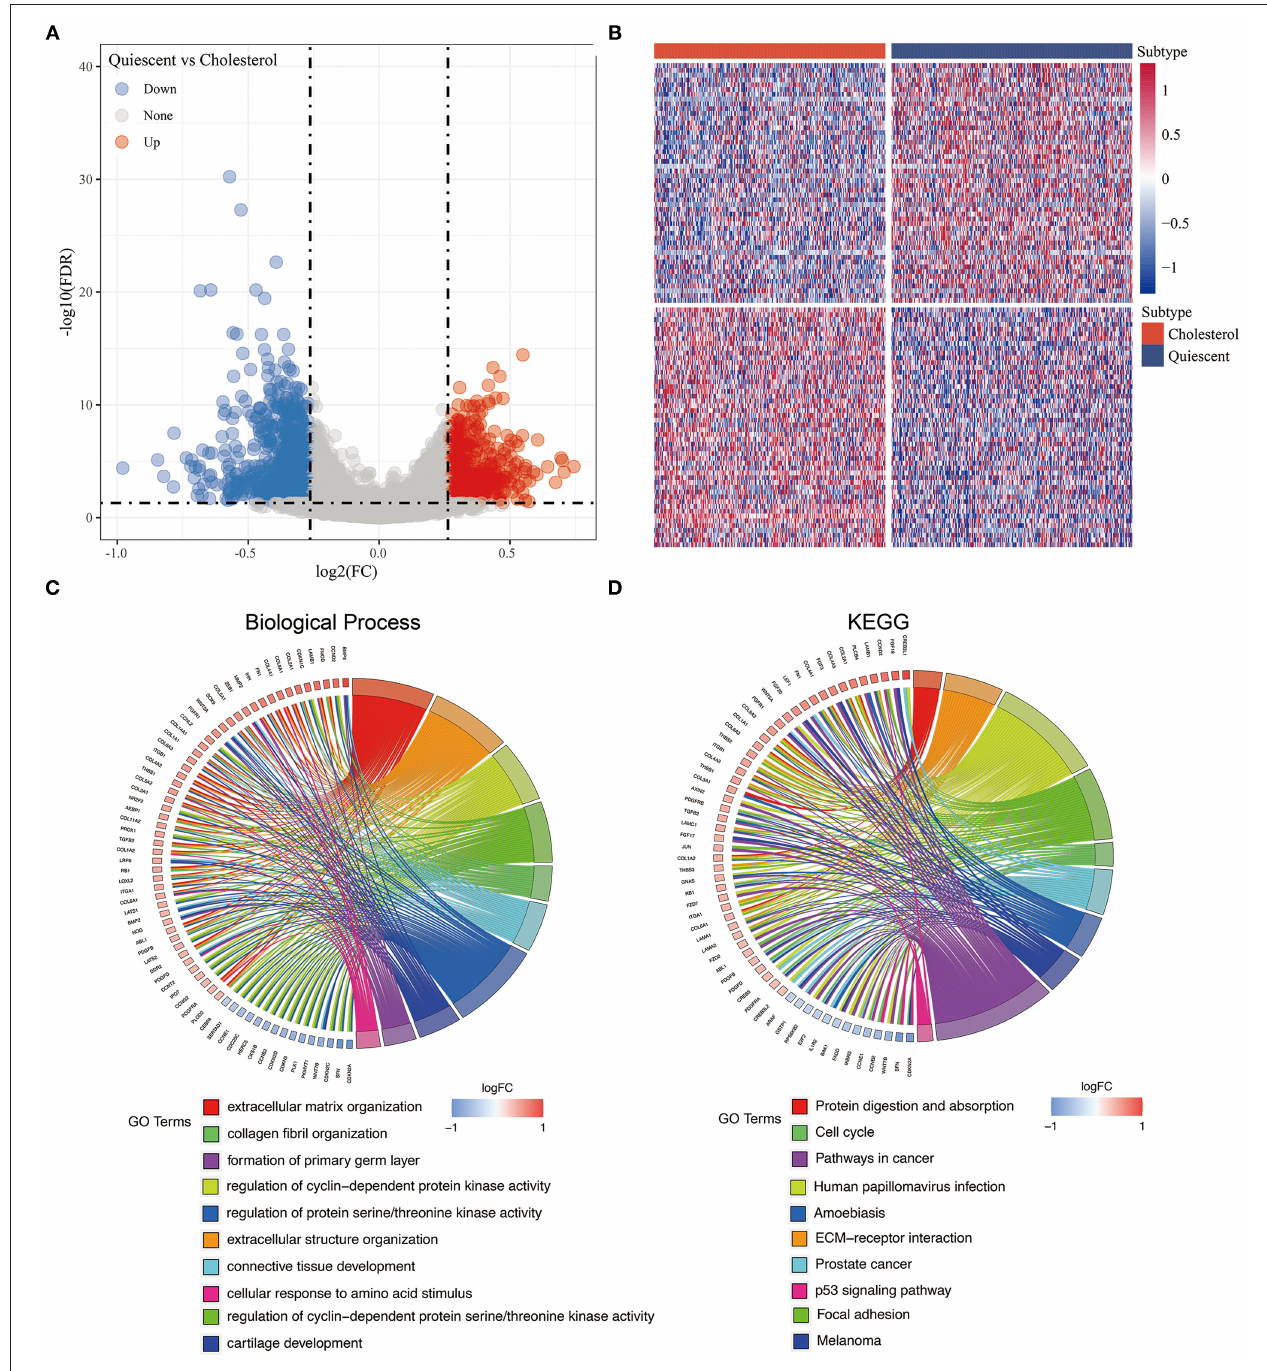
FIGURE 5 | (A) The volcano map of the differentially expressed genes in cholesterol and quiescent subtype in the TCGA data set; (B) The heatmap of the differentially expressed genes in cholesterol and quiescent subtype in the TCGA data set. (C) Biological process enrichment of differentially expressed genes. (D) KEGG pathway enrichment of differentially expressed